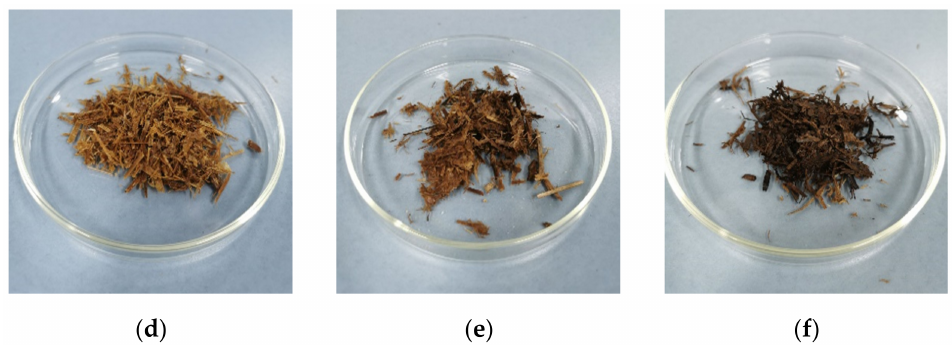
Figure 3. Photographs of untreated wheat straw ( a ) and hydrothermally pretreated wheat straw samples with different pretreatment severity ( b ) HTP-160-15; ( c ) HTP-160-45; ( d ) HTP-170-30; ( e ) HTP- 180-15; ( f )